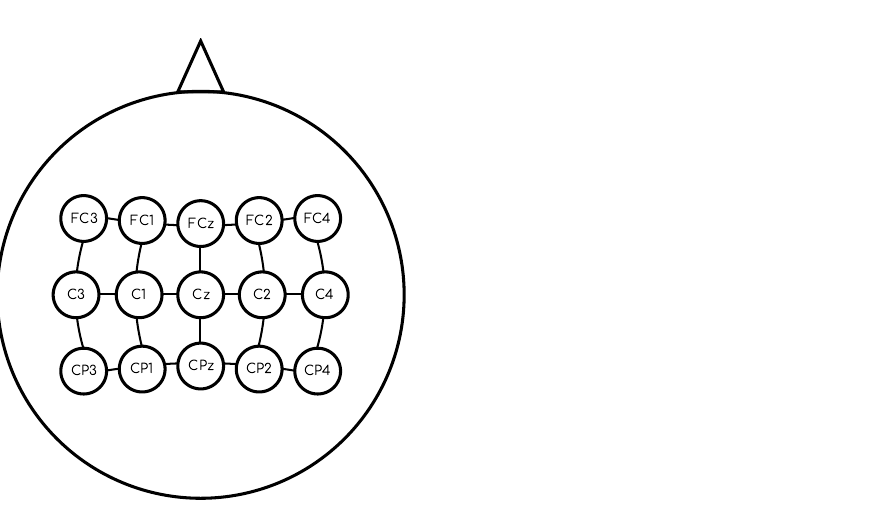
Figure 1. Electrode positions according to the 10–20 coordinate system used for the acquisition of the Electroencephalography (EEG) signals